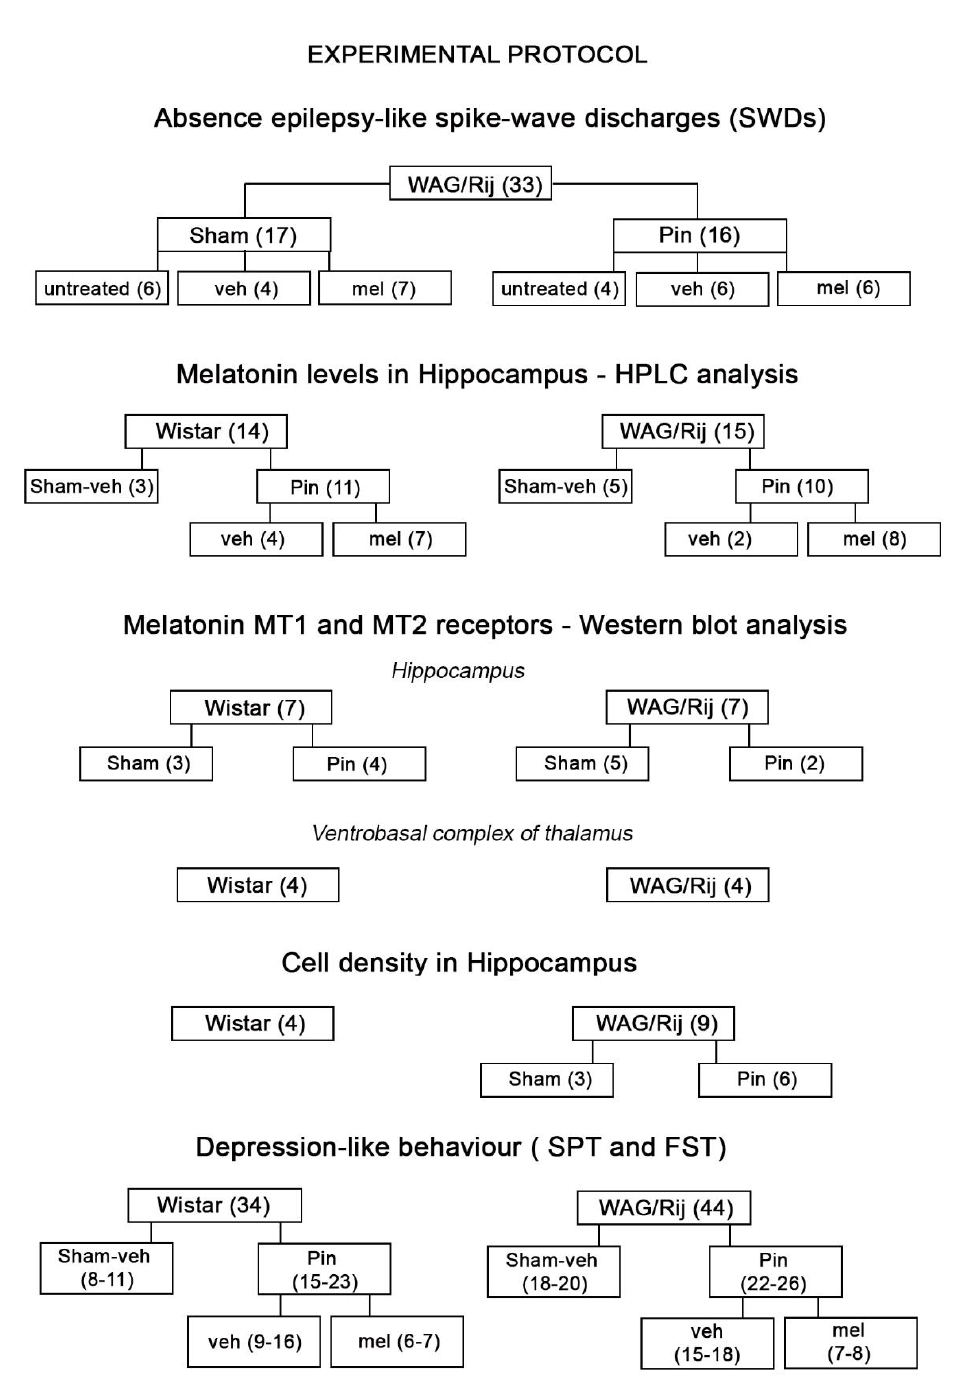
Scheme 1. Schematic illustration of the experimental protocol. Groups and number of animals used are shown. The number of animals for the behavioral experiments are shown as total number per group for both tests (SPT and FST). The animals used for determination of melatonin levels and expressions of melatonin receptors were from the cohort of animals used for behavioral